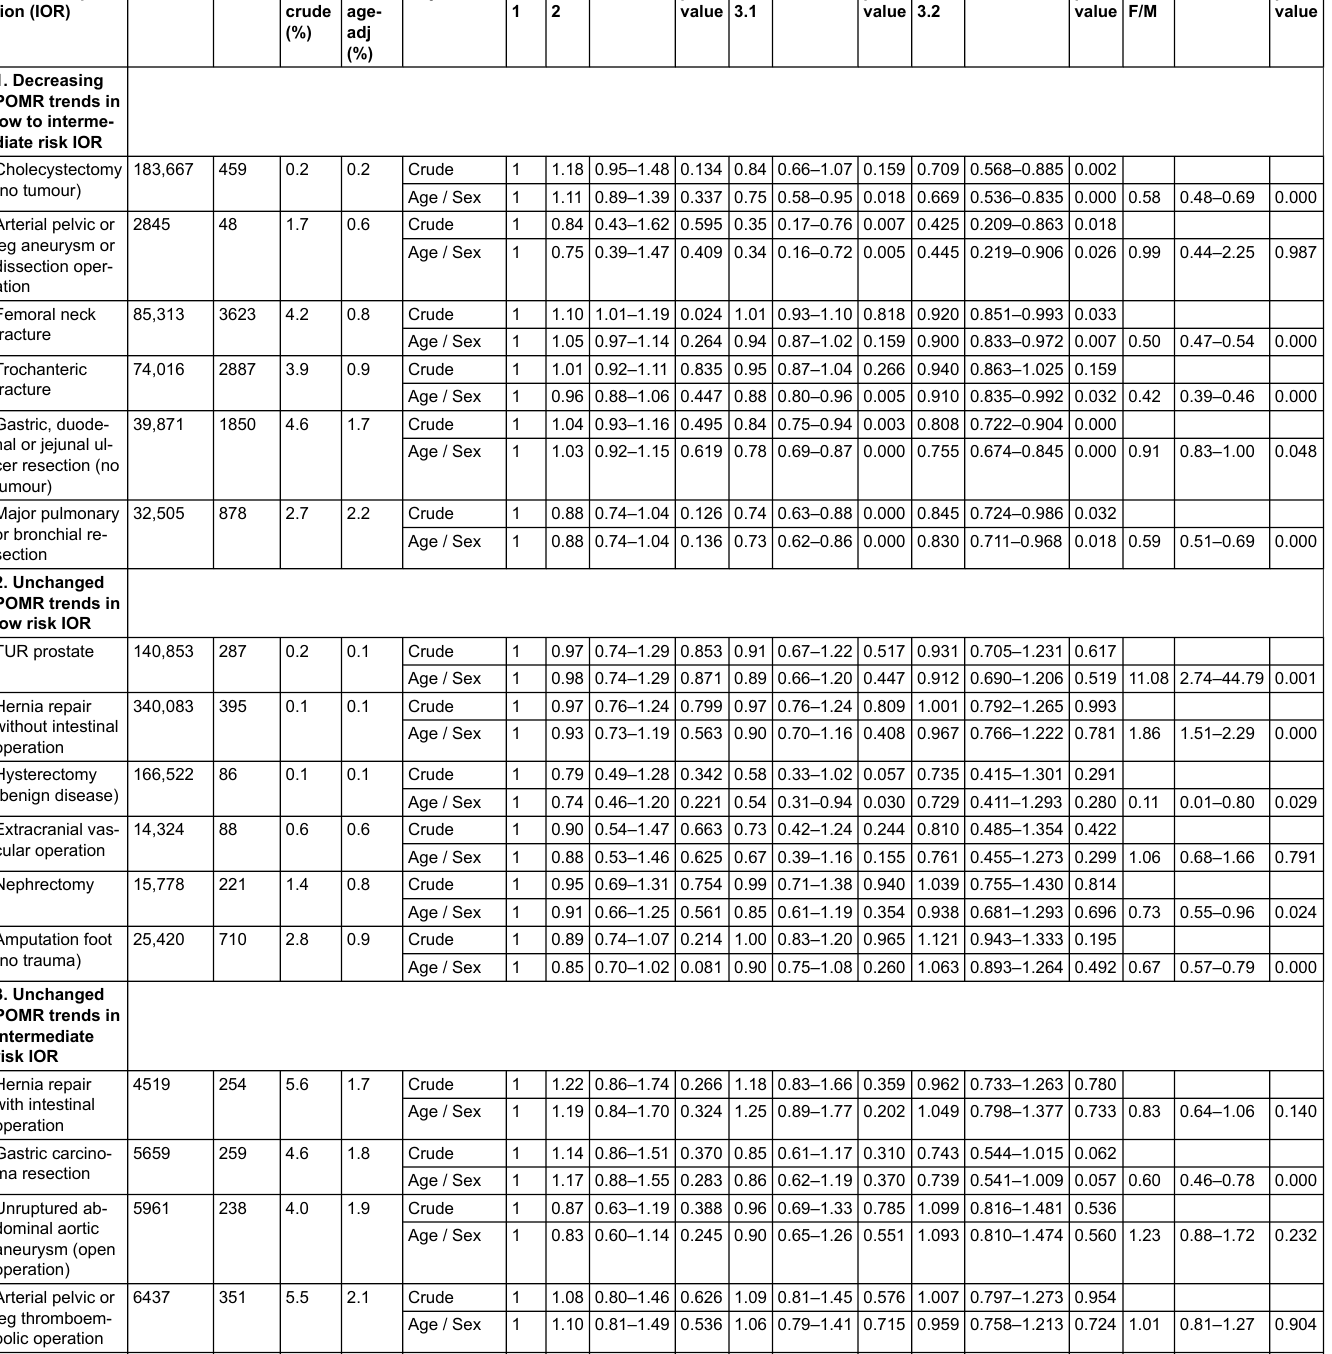
Table 3: Decreasing, unchanged, and increasing POMR time trends 1998–2014 for 22 indicator operations with various perioperative risk. Indicator opera- tion